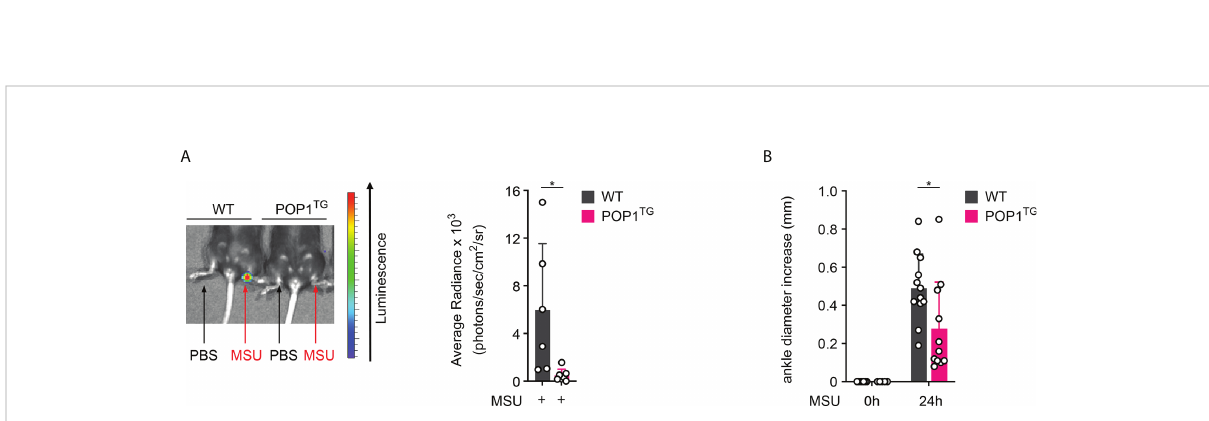
FIGURE 2 POP1 ameliorates MSU-induced joint in fl ammation in mice. (A) In vivo imaging of MPO activity correlating to PBS (left ankle) or MSU (right ankle)-induced neutrophil in fi ltration into the hind limb ankle joint in wild type (WT) and POP1 transgenic (POP1 TG ) mice 24h after PBS or MSU crystal injection (left) and average radiance (right) presented as photons/sec/cm 2 /sr (n = 5 - 6 ± s.d.). (B) The ankle diameter was measured with a caliper before and 24h after MSU crystal injection into the hind limb ankle joint in WT and POP1 TG mice (n = 11 - 12 ± s.d.). *p <